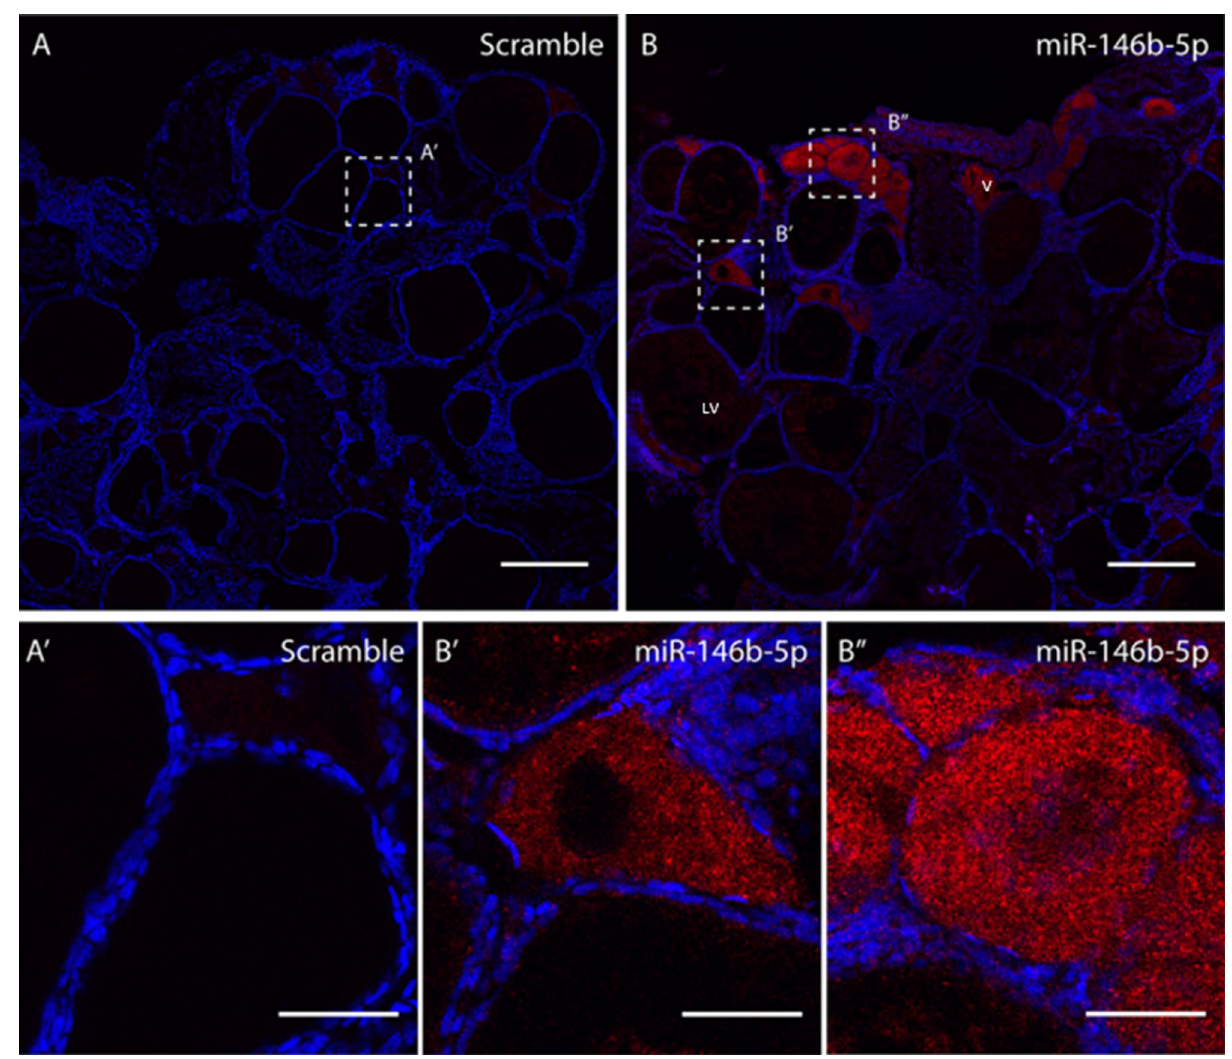
Figure 6. Fluorescent in situ hybridization (FISH) of dre-miR-146b-5p in the ovary of adult zebrafish. A total of 6 female fish were used to obtain the results. ( A ) Sections A and A’ showed scramble probe. Section B, B ′